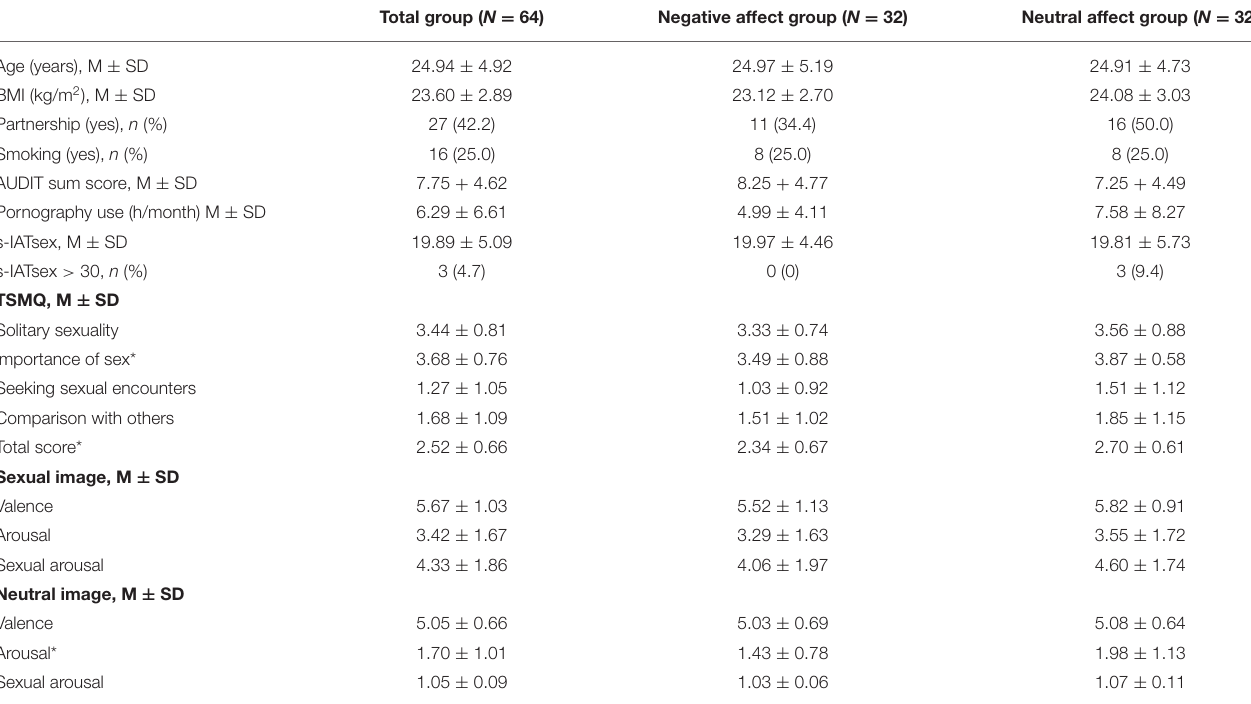
TABLE 1 | Baseline characteristics of total sample and separately for both